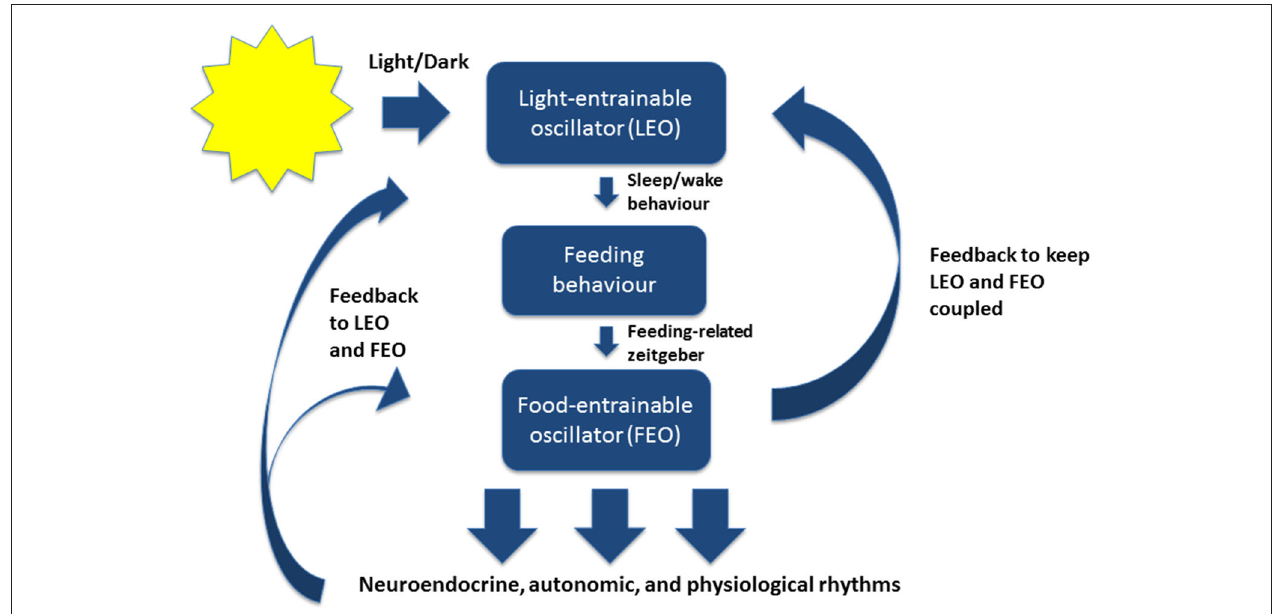
influence the timing of feeding behavior, which entrains the food- entrainable oscillator (FEO). FEO then drives several neuroendocrine, autonomic, and physiological rhythms throughout the brain and peripheral nervous system. The FEO also sends feedback to the LEO to remain coupled. Under certain conditions when the LEO is dysfunctional, or under conditions of constant darkness, the FEO can drive rest-activity rhythms and other rhythms normally entrained by